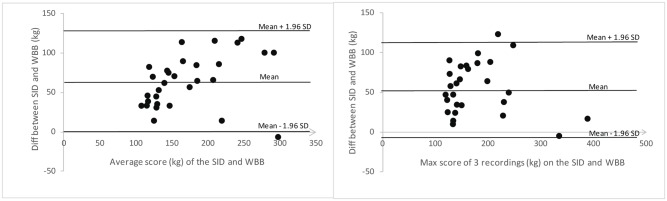
Bland-Altman plots representing comparisons between the SID and the WBB on the first occasion using (A) a mean of three recordings and (B) the maximum of three recordings.The mean line represents the mean difference between the devices, with the upper and lower lines representing the limits of agreement (1.96 SD).